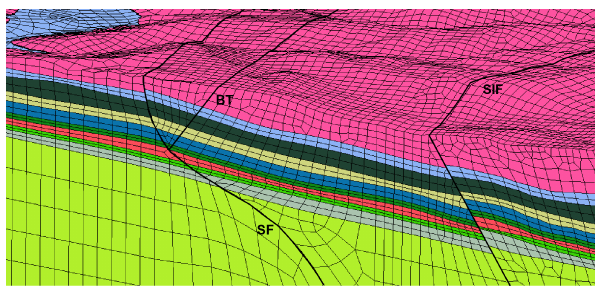
Figure 4. Discretized model volume viewed from southwest. Thick black lines indicate the faults that are implemented as contact sur- faces with Coulomb friction. Colour-coded are the individual ge- omechanical units and BT denotes